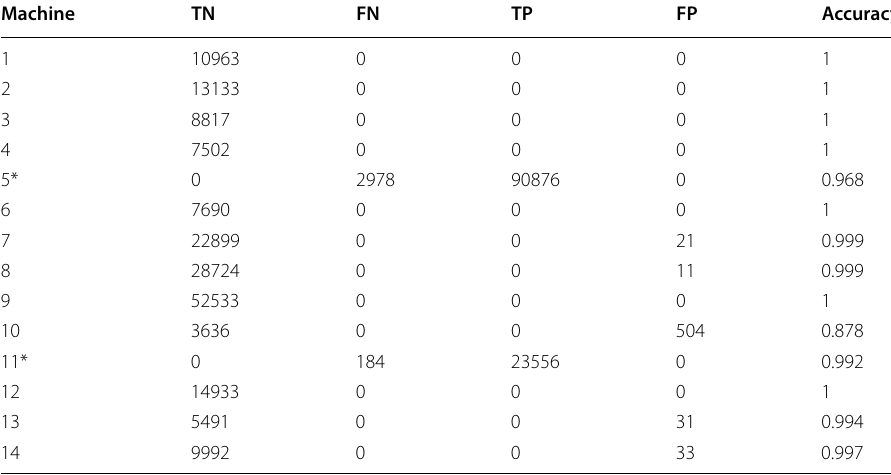
Table 2 CNN classification